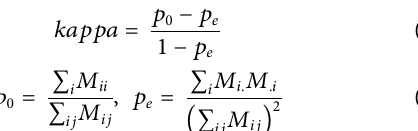
( Table 1 ), PPA-GCN is well adapted to all three genera.